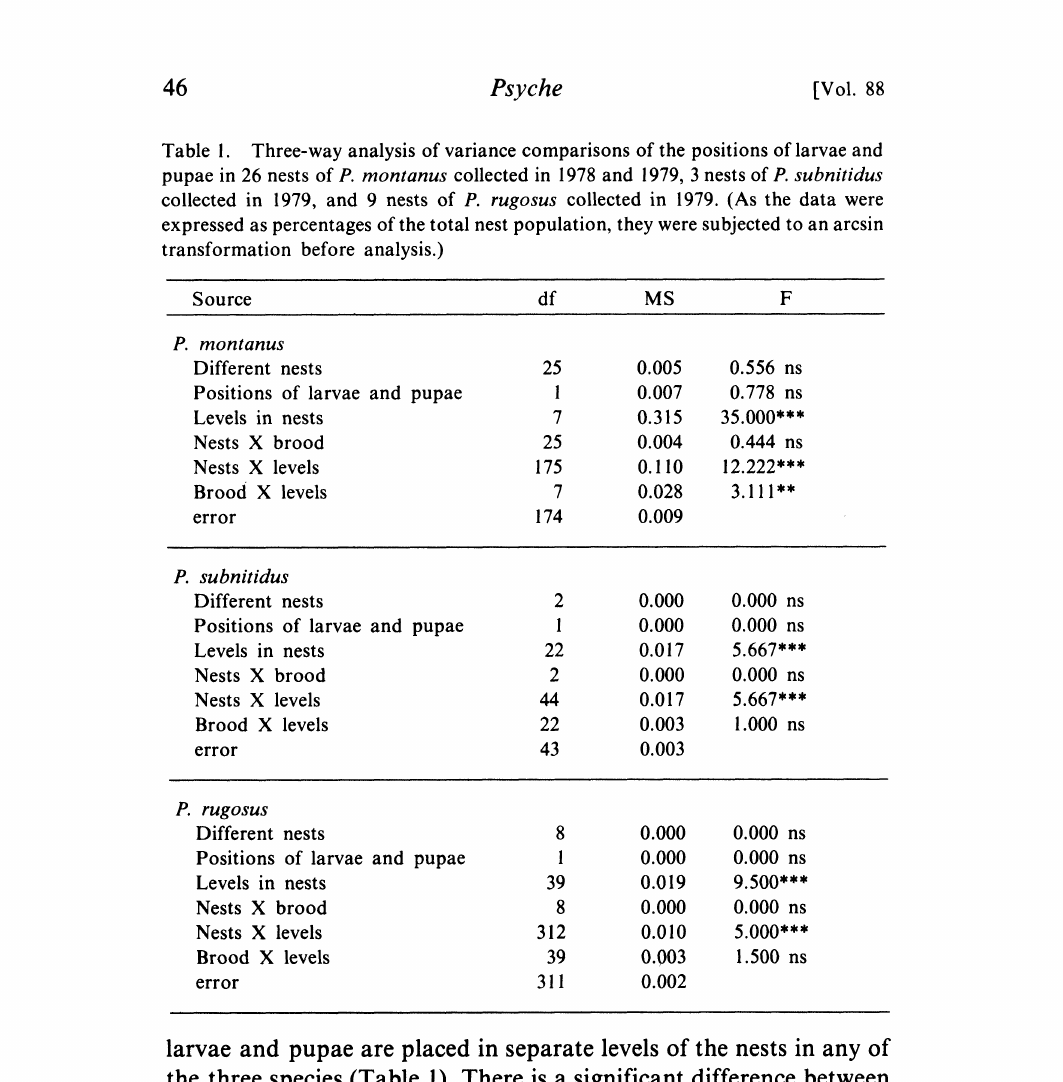
Psyche [Vol. 88 Table 1. Three-way analysis of variance comparisons of the positions of larvae and pupae in 26 nests of P. montanus collected in 1978 and 1979, 3 nests of P. subnitidus collected in 1979, and 9 nests of P. rugosus collected in 1979. (As the data were expressed as percentages of the total nest population, they were subjected to an arcsin transformation before